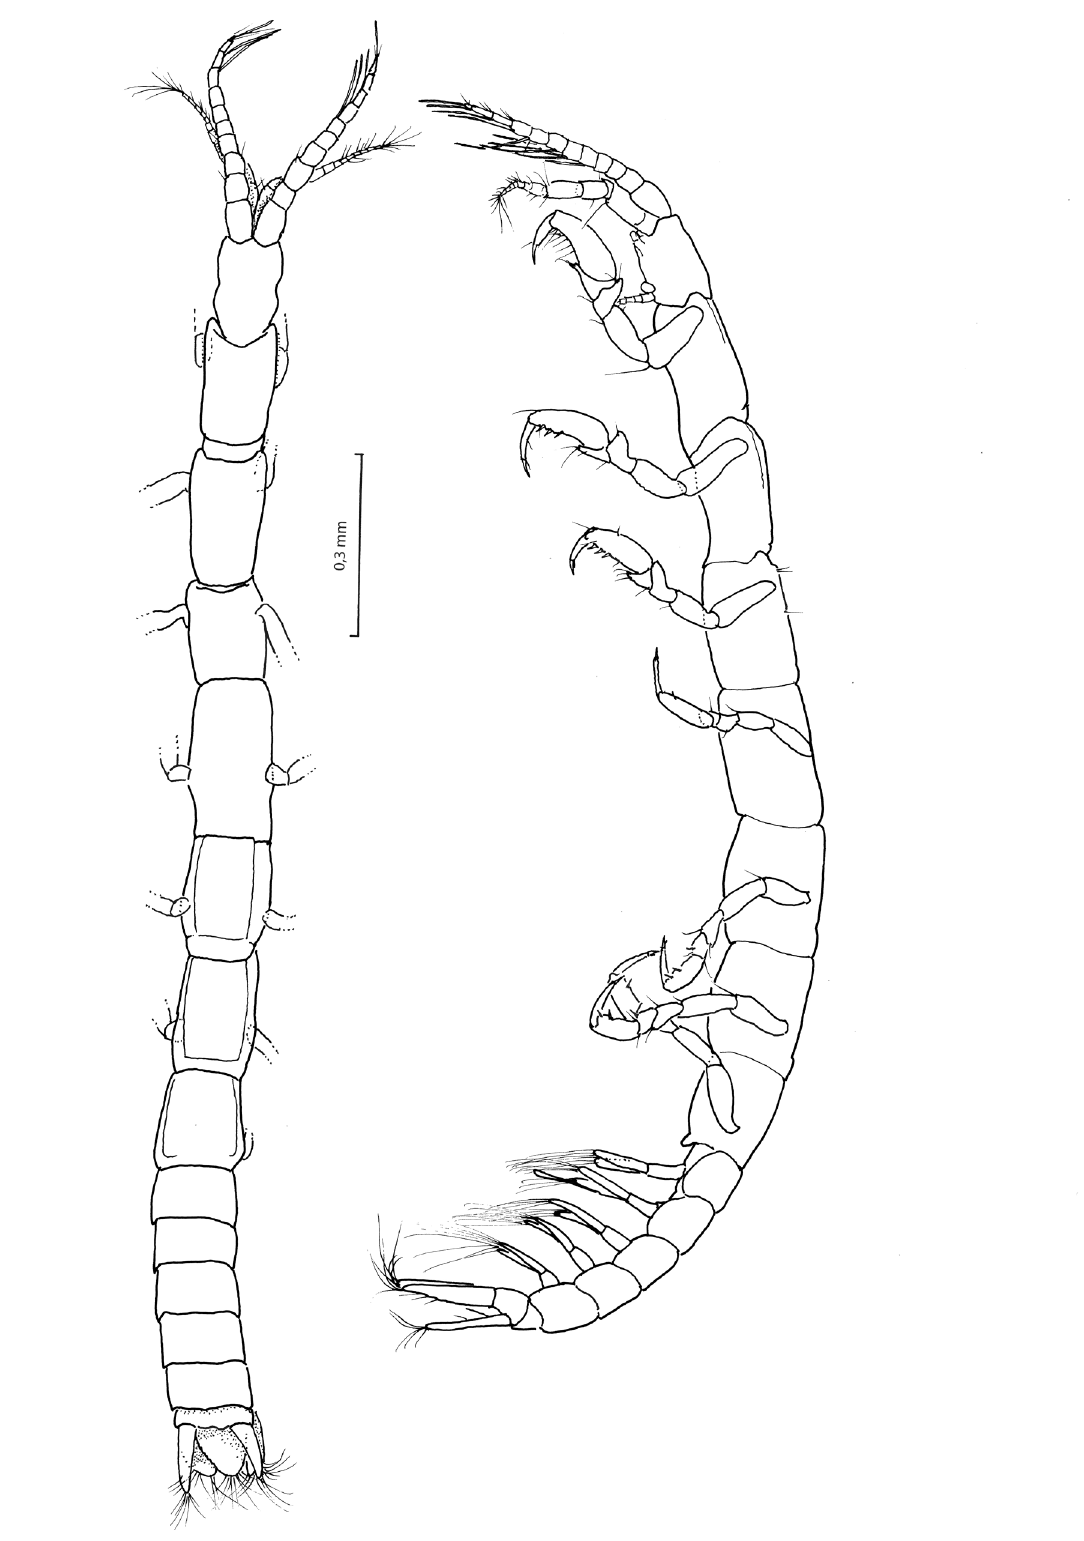
Fig. 2. Hyssura reptans sp. nov., ♂, holotype in dorsal and lateral view (2.1 mm) (MZB Iso